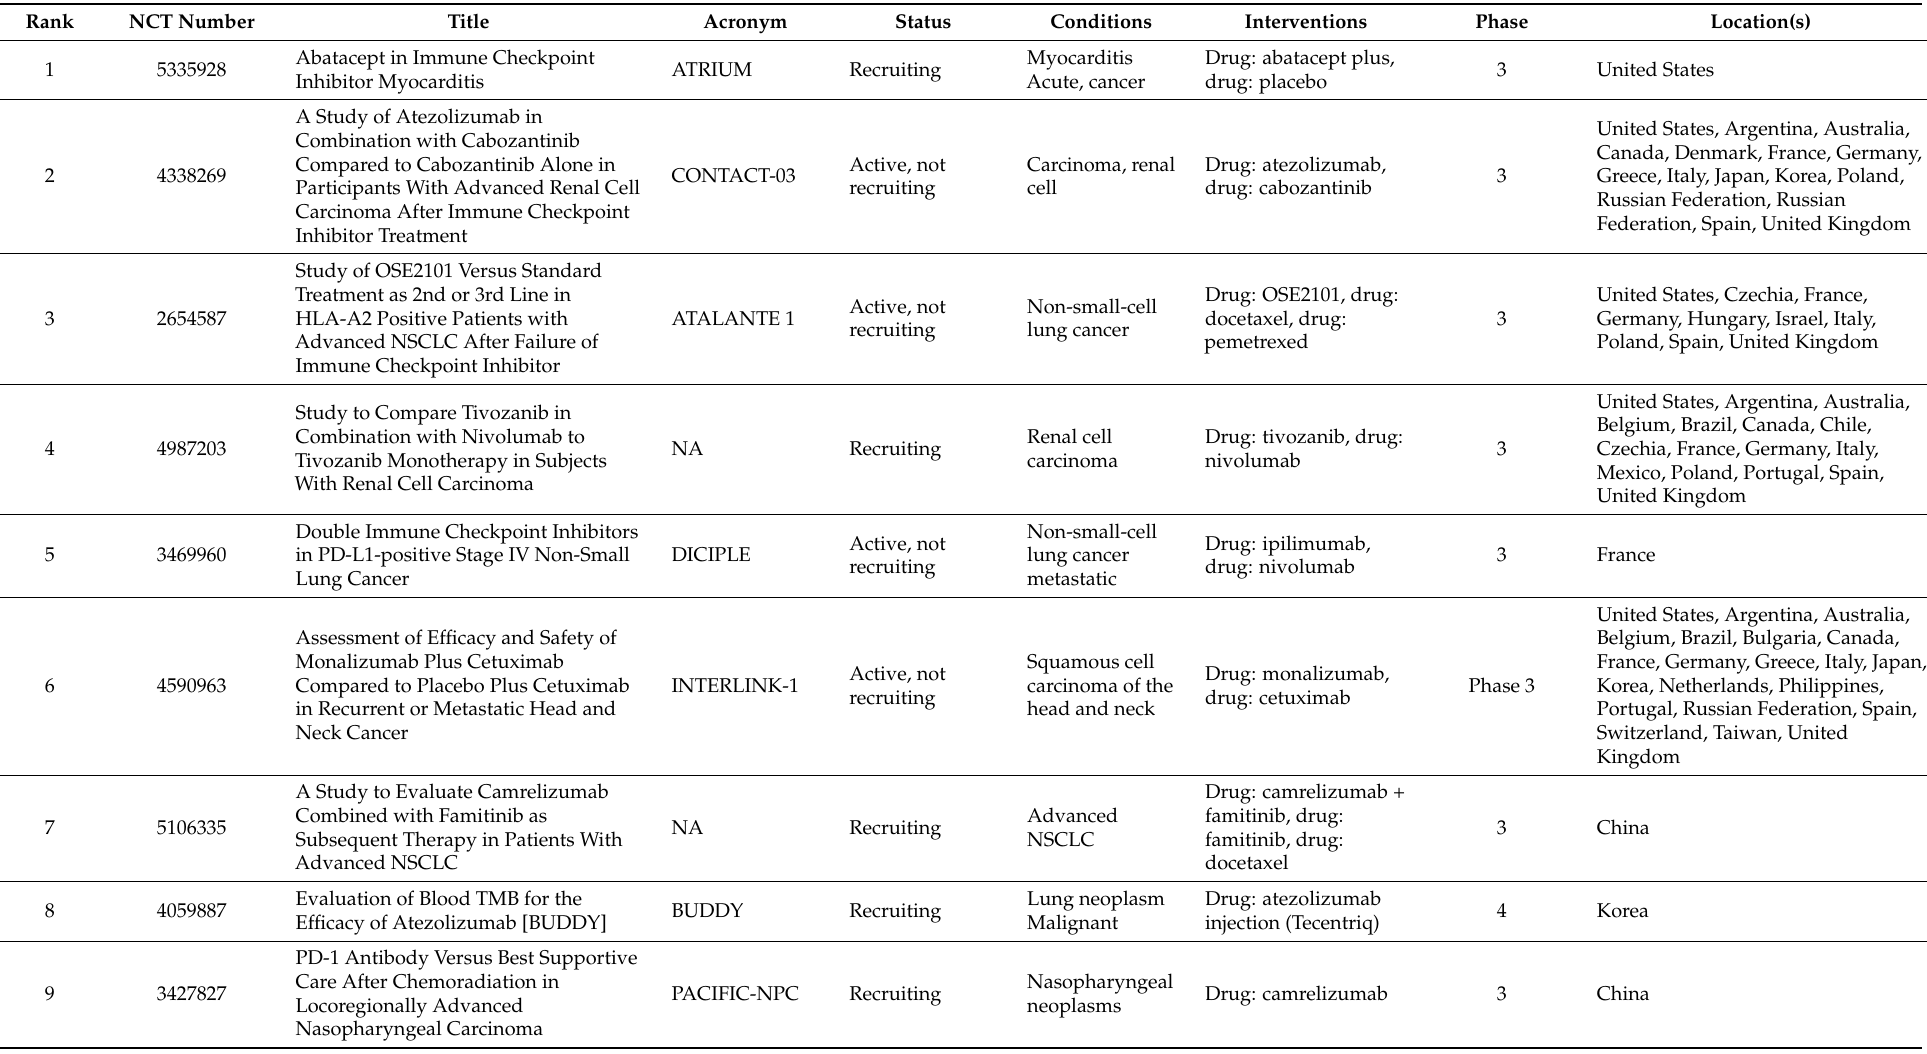
Table 2. Ongoing stage 3 or 4 active clinical trials that involve